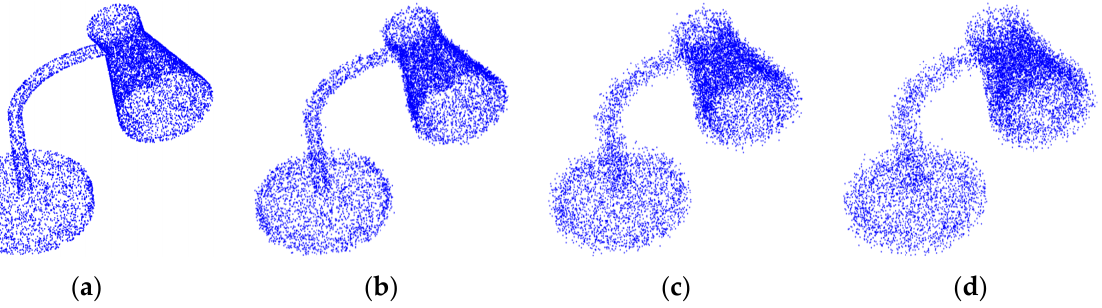
Figure 4. Examples of point cloud with different variance of Gaussian noise. ( a ) Model without noise; ( b ) σ = 0.01; ( c ) σ = 0.03; ( d ) σ = 0.05. The C (cid:101) D -noise curve in Figure 5 shows the C (cid:101) D with different noise magnitudes.